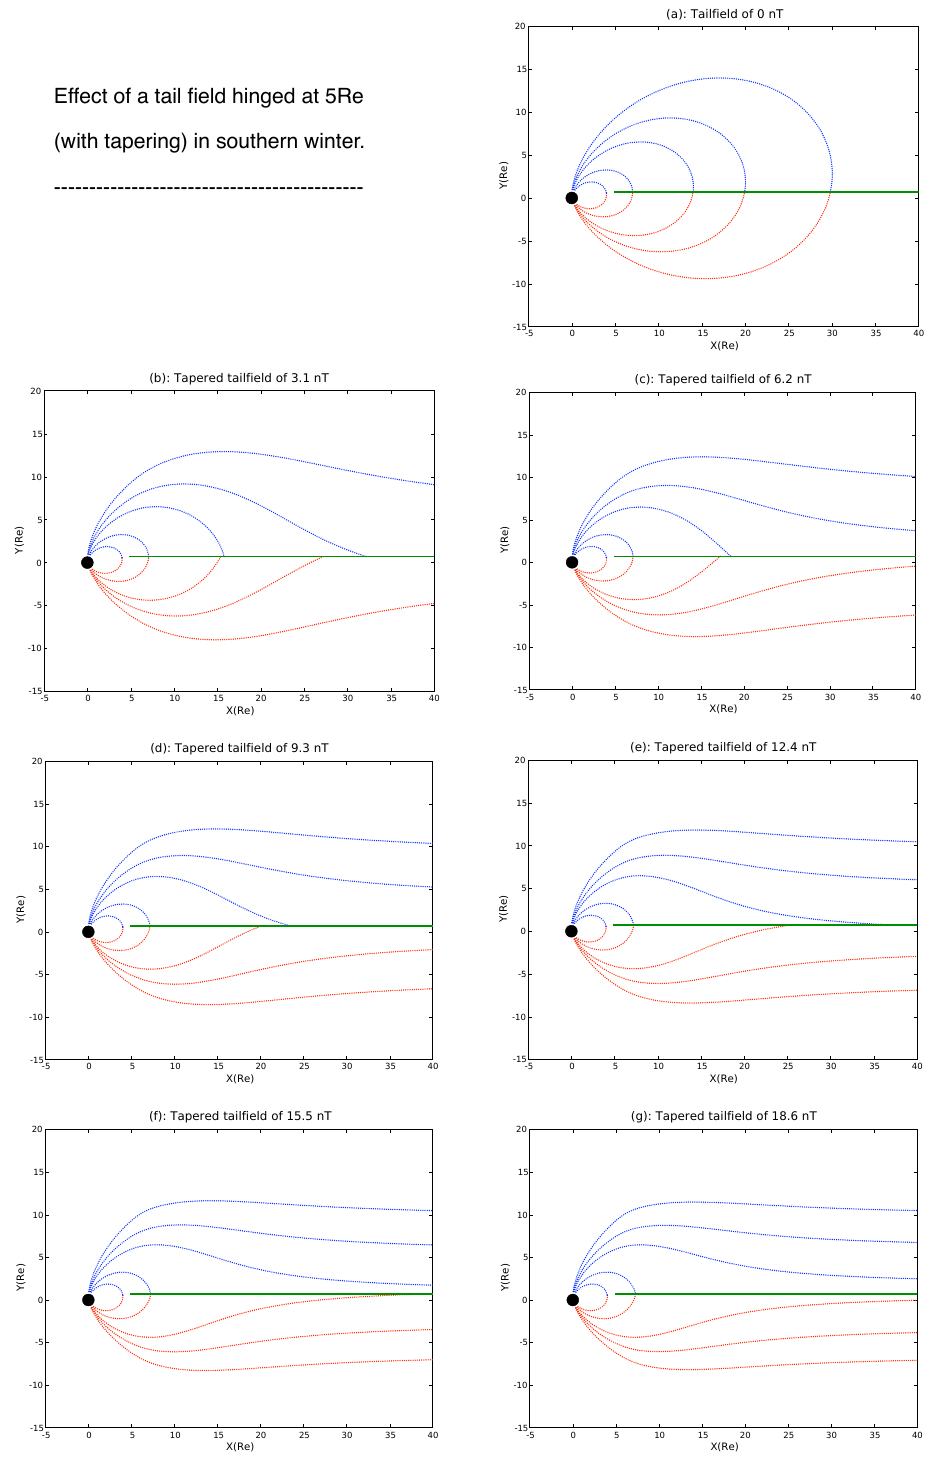
Fig. 8. Night-side field tracings for the southern winter and northern summer, the angle between geomagnetic equator and ecliptic plane being 8 ◦